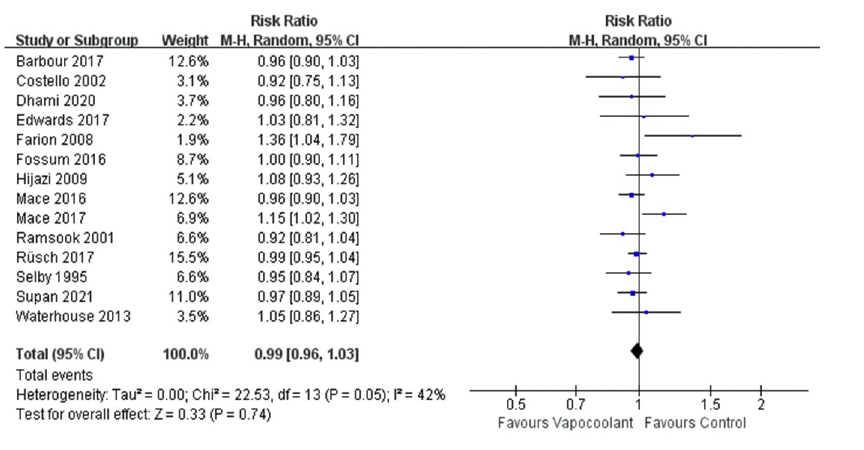
Fig 11. Forest plot of first attempt success rate.